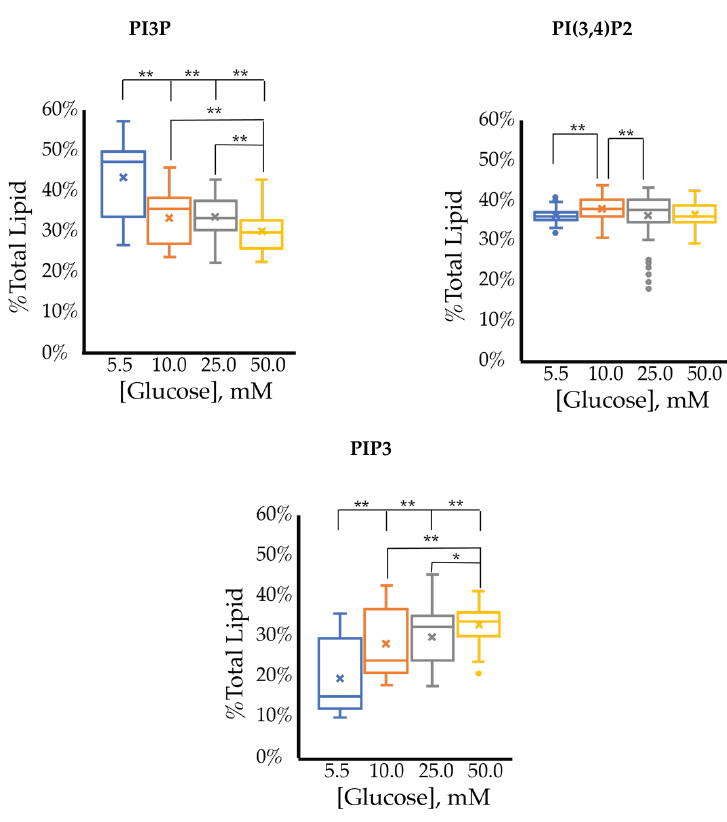
represent 30 µ m.